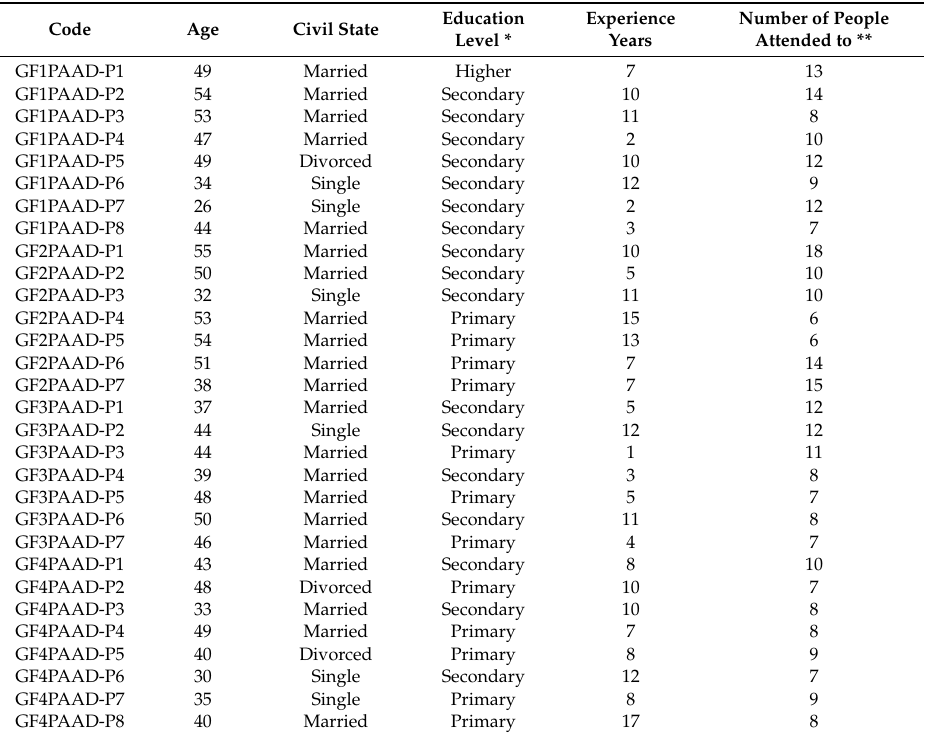
Table 2. Sociodemographic characteristics of